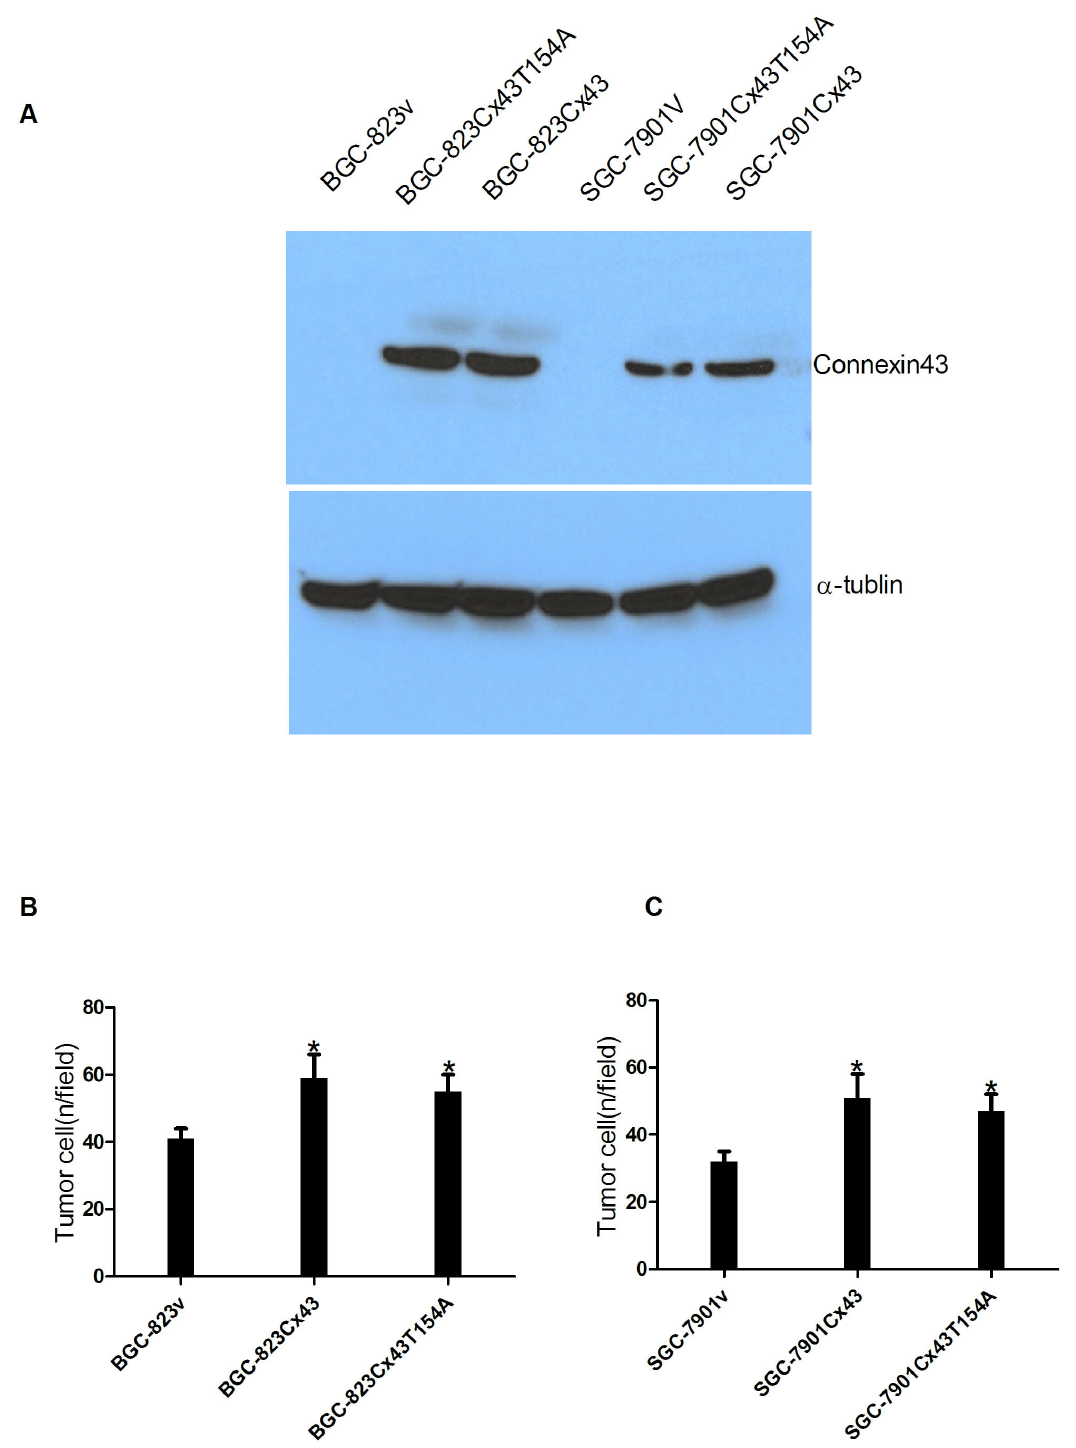
Figure 2. Effects of Cx43 on in vitro adhesion of BGC-823 and SGC-7901gastric cancer cells to mesothelial cells after transfection. (A) Cx43 and Cx43T154A expression of BGC-823 and SGC-7901 gastric cancer cells after transfection. (B, C) Effects of Cx43 on in vitro adhesion of BGC-823 and SGC-7901 gastric cancer cells to mesothelial cells. Adherent tumor cells were counted (magnification: ×200), the results showed that adhesion of cells transfected with Cx43 or Cx43T154A was significantly increased compared to that of cells transfected with empty vector (*P<0.05). Data are presented as the mean± SEM. doi: 10.1371/journal.pone.0074527.g002 PLOS ONE |